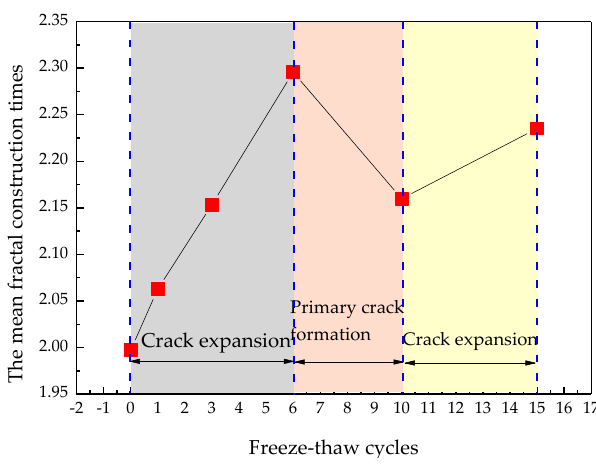
Figure 14. The relationship between the mean fractal construction times and freeze-thaw cycles.